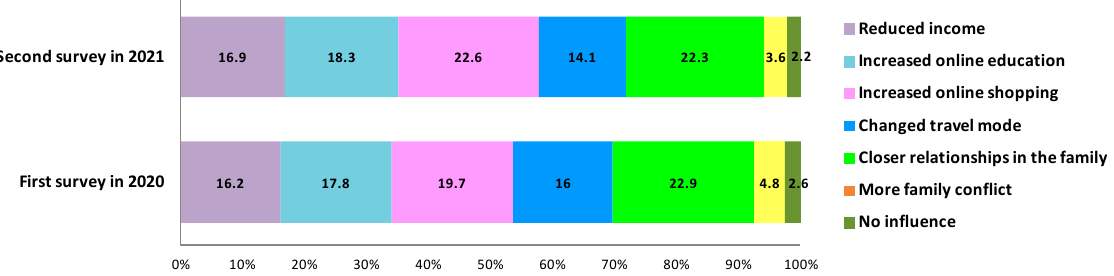
Figure 2. The effect of the pandemic on daily life of residents.